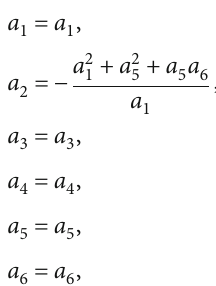
Figure 1: Pro fi les of the solution u via (12a) and pro fi les of the solution v via (12b) with a a 9 = 1 . (a) and (c) are the corresponding 3-dimensional plots; (b) and (d) are the corresponding density